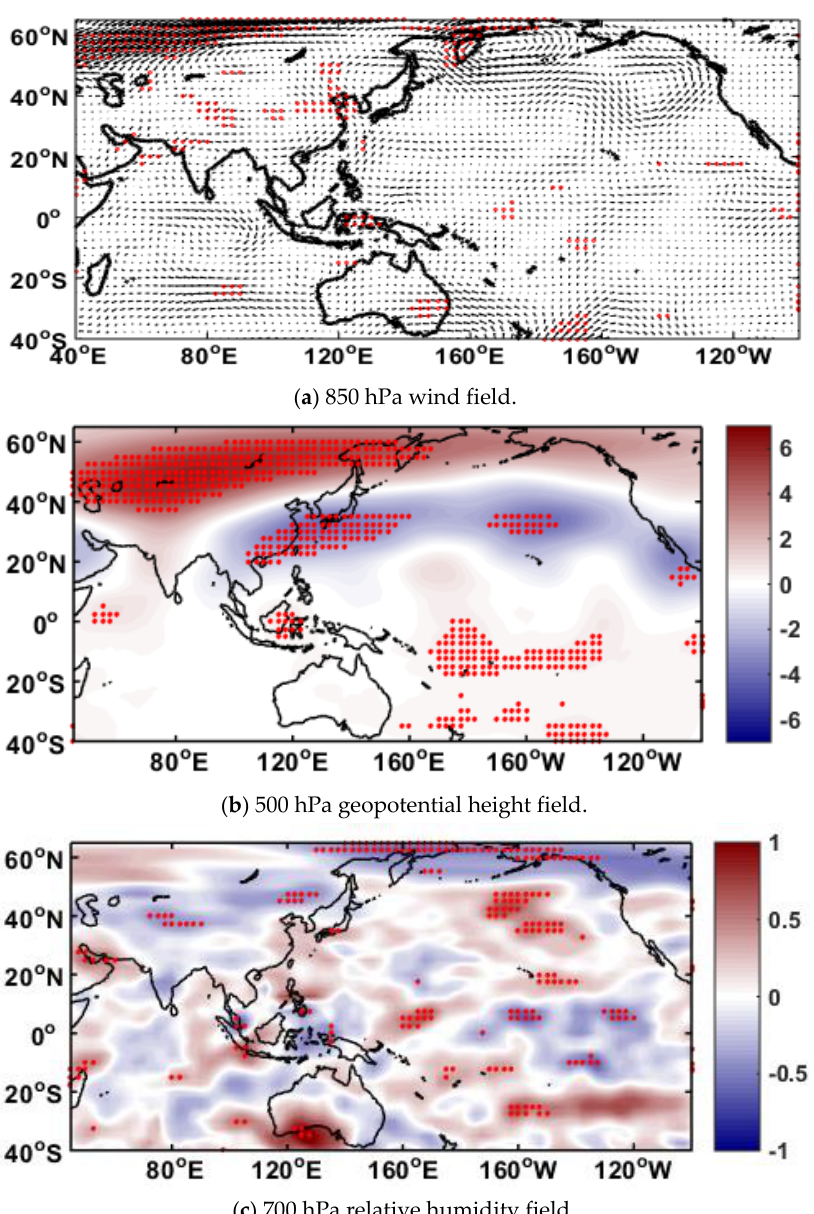
Figure 5. Regression maps based on TIOD (the marked areas indicate statistically significant values at the 5% level).